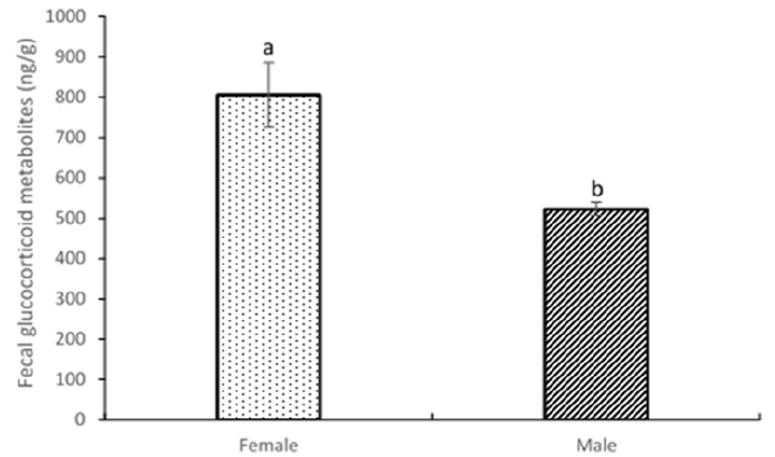
Figure 4. Fecal glucocorticoid metabolite concentrations (fGCM) ± standard error of the mean (S.E.M.) between different sexes. Values with distinct superscript letters (a, b) denote statistical differences ( p value < 0.10) among groups using the U Mann–Whitney test.